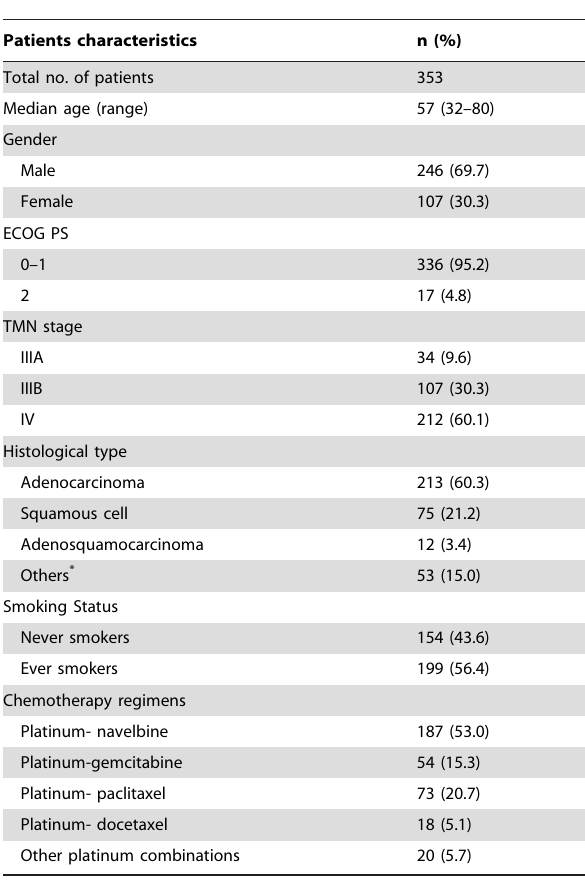
Table 1. Clinical characteristics of NSCLC